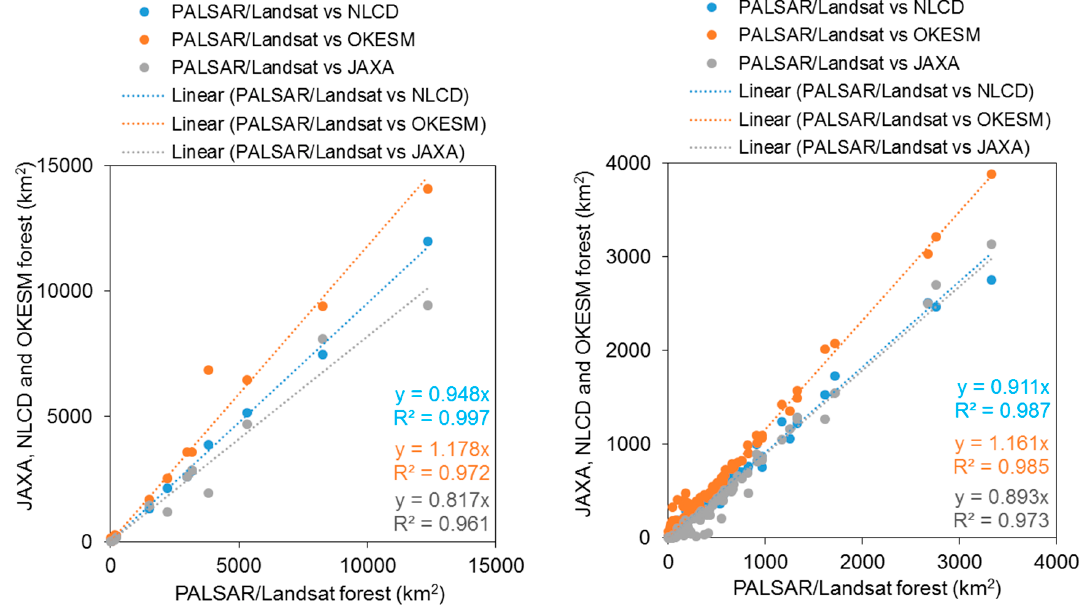
Figure 10. Linear relationships of forest area between the PALSAR/Landsat forest map and JAXA forest map, NLCD2011 forest map, and OKESM forest map in ecoregions and counties in 2010.